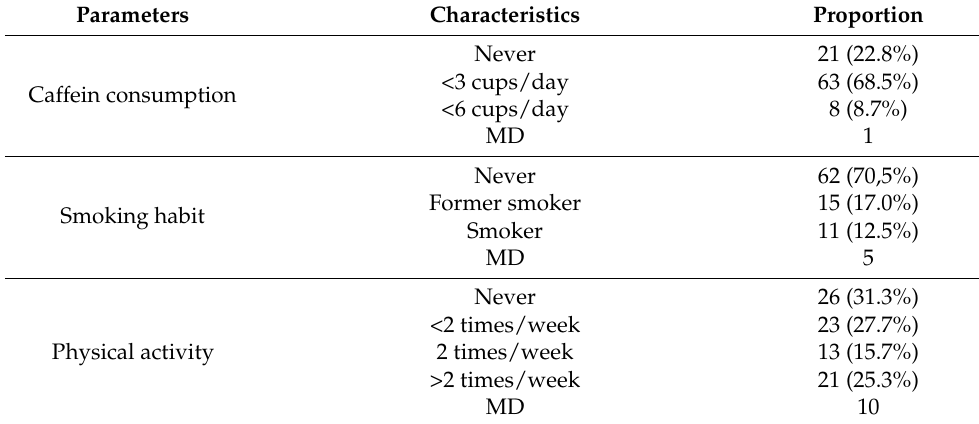
Table 1. Cont. Parameters